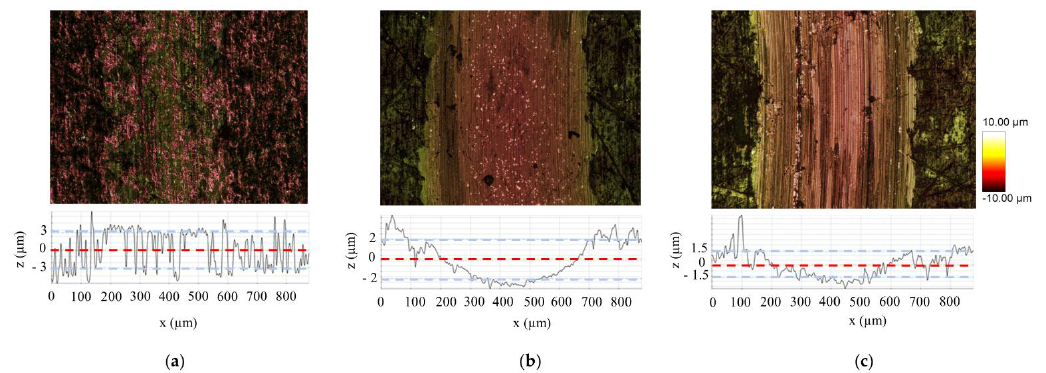
Figure 8. Optical profilometry of wear tracks of the GHA / Si 3 N 4 system: ( a ) GHA10, ( b ) GHA50 and ( c ) GHA100.